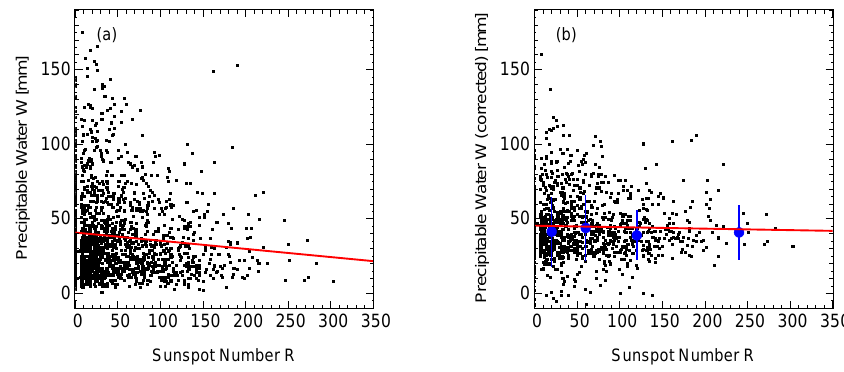
Fig. 4. (a) Precipitable water content W versus sunspot number for Cerro Montezuma and airmass 2.5, showing a very similar trend to the one presented in Figure 1 of W10. The linear slope has a value of − 0 . 055 ± 0 . 014 . (b) Same as before, but for the corrected values of the precipitable water contient, i.e. with the deviation of the monthly medians from the annual average subtracted to correct for seasonal variations, and without the data from years affected by volcanic aerosols or local pollution. The red line indicates a linear regression to the data, showing no statistically significant trend with sunspot number (slope − 0 . 010 ± 0 . 014 ). The blue circles and their error bars illustrate medianvaluesandthevarianceinfoursunspot-numberintervals.